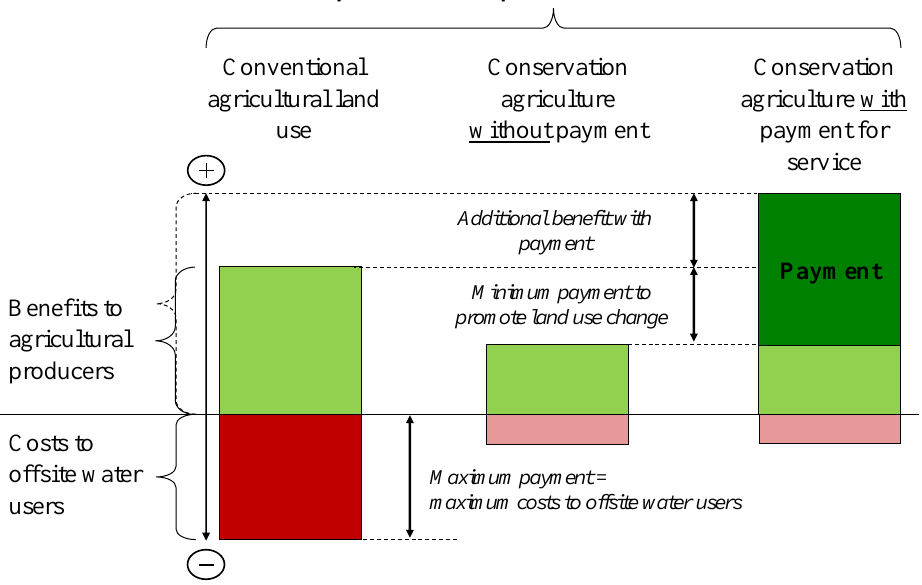
Fig. 1. Theoretical illustration of the overall benefits from an ecosystem service payment scheme compared to conventional agricultural land use and conservation agriculture without